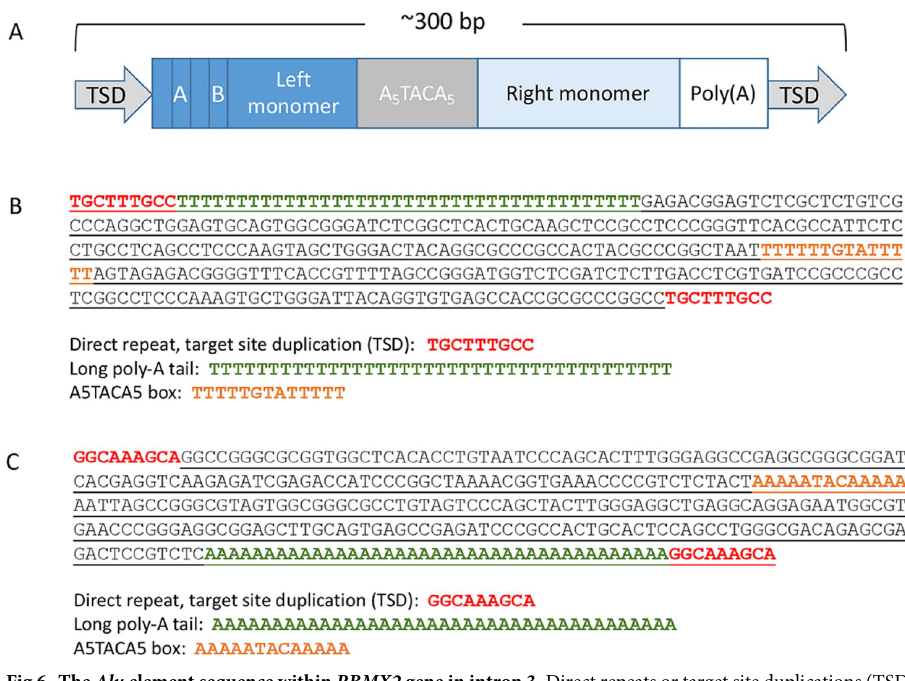
Fig 6. The Alu element sequence within RBMX2 gene in intron 3. Direct repeats or target site duplications (TSDs) are shown in red, A 5 TACA 5 box is shown in orange, and the long poly-A tail is shown in green. The 330 bp deleted sequence is underlined. ( a ) A structural scheme of an Alu element(21). ( b ) The sequence of the Alu element on the antisense strand (in relation to the RBMX2 gene) in the GRCh38.p13 primary assembly ( > NC_000023.11:130,405,825–130,406,163 Homo sapiens chromosome X). ( c ) The reverse complement sequence of the Alu element in the GRCh38.p13 primary assembly ( > NC_000023.11:c130,406,163–130,405,825 Homo sapiens chromosome X).